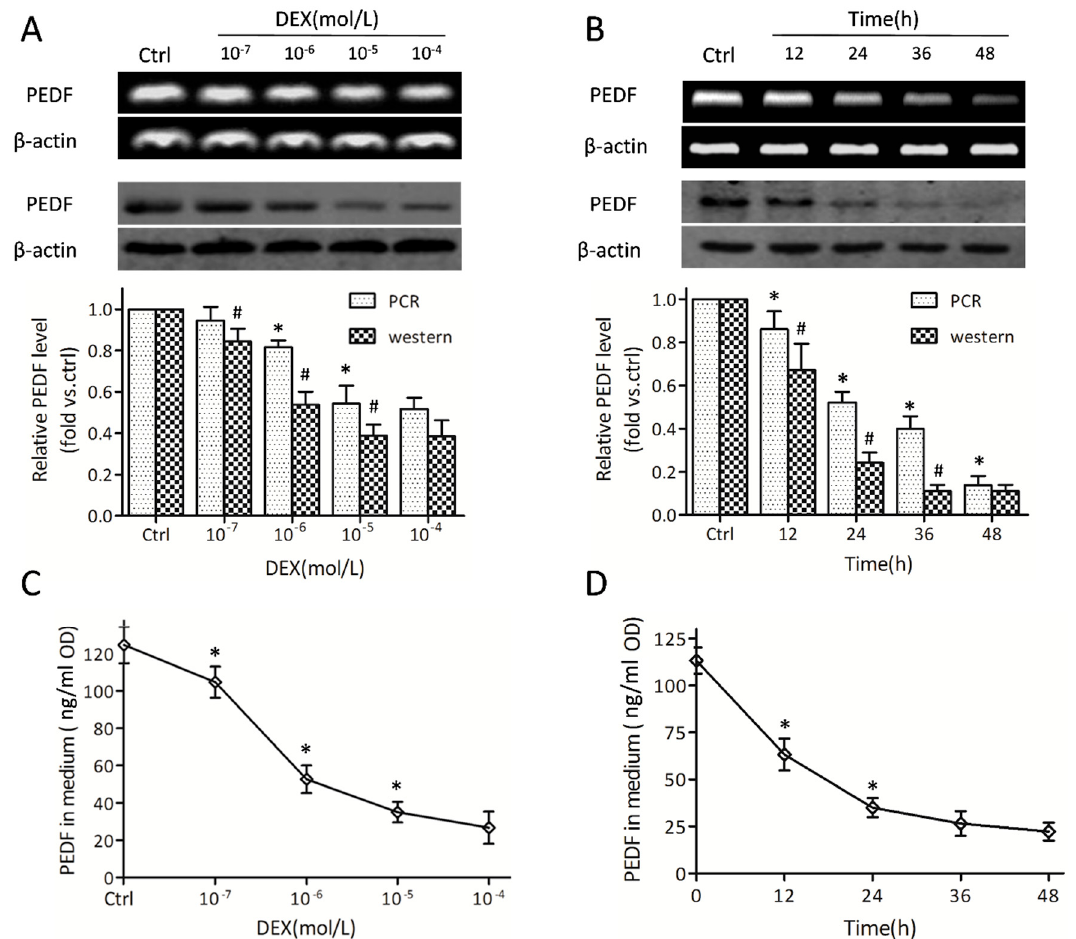
Figure 2. Dexamethasone down-regulates pigment epithelial-derived factor (PEDF) in MC3T3-E1 pre-osteoblasts. MC3T3-E1 pre-osteoblasts were exposed to DEX at different concentrations (10 − 7 , 10 − 6 , 10 − 5 , and 10 − 4 mol/L) for 24 h; in addition, cells were incubated with 10 − 5 mol/L DEX for different times (0, 12, 24, 36, and 48 h). ( A , B ) PEDF mRNA levels ( upper panels) and protein levels ( lower panels) were detected by RT-PCR and Western blot, respectively ( n = 5, * p and # p < 0.05 vs. the two adjacent groups). Data were expressed in fold induction, relative to control; ( C , D ) The PEDF protein secreted into the medium was tested by ELISA, with results normalized to the corresponding protein concentration ( n = 5, * p < 0.05 vs. the two adjacent groups). Data are mean ± SD.